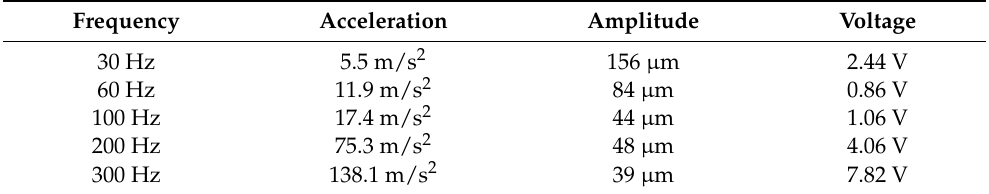
Table 1. Acceleration, amplitude, and input voltage at each frequency of the vibratory stimuli used in Experiment 1. Accelerations and amplitudes of the stimuli were 3 dB higher than the thresholds at which the vibration-weight illusions were observed at individual frequencies. Voltage indicates the amplitude of the voltage applied to the voice coil motor (half to peak-to-peak). Frequency Acceleration Amplitude Voltage 30